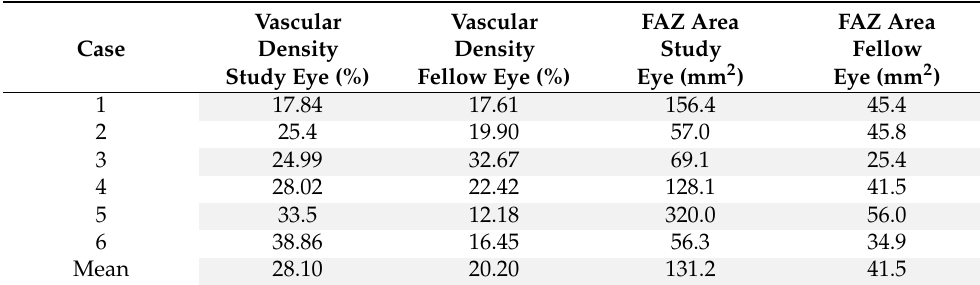
Table 2. Comparison of macular microvascular parameters between closed macular hole and the fellow unoperated-upon